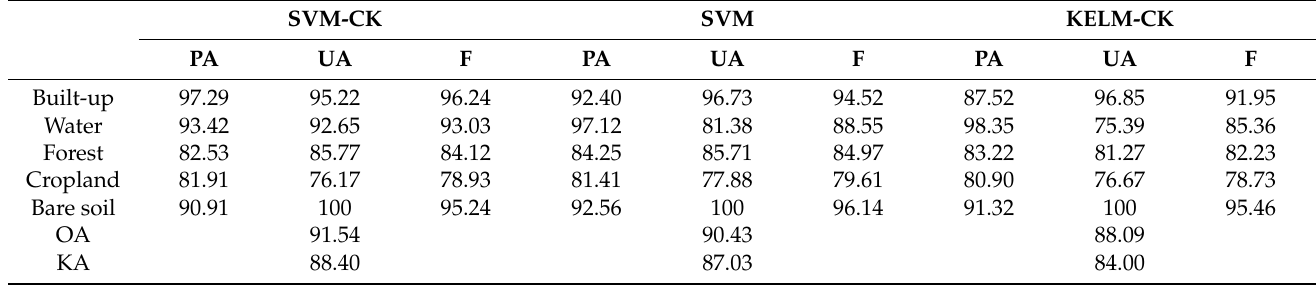
Table 5. Accuracy assessment of the classification results using three different algorithms with the Sentinel-2B MSI data (all in percent).